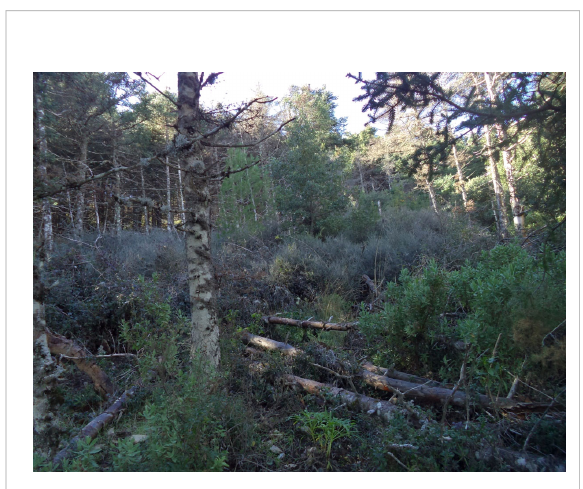
FIGURE 9 Forest gap caused by the dieback process and its recolonization and vegetation. Picture taken in the 2020 fi eld